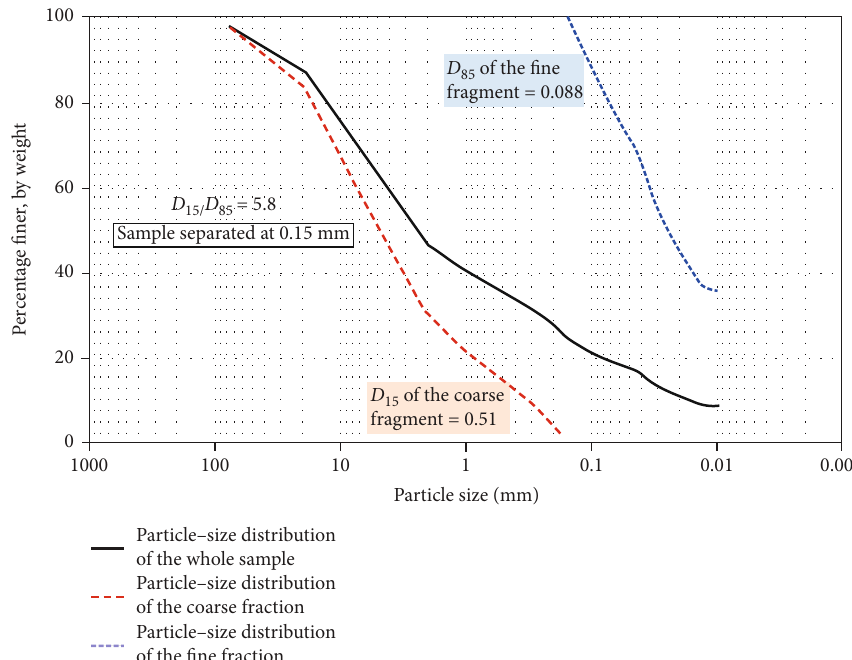
Figure 15: Illustration that shows the determination of D size distribution separated at 0.15mm particle